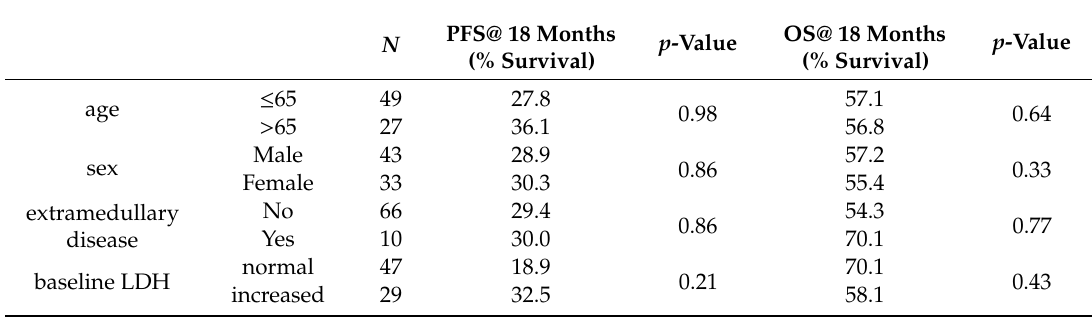
Table 5. Univariate analysis of PFS and overall survival (OS) at 18 months in RRMM patients treated with PomaD.